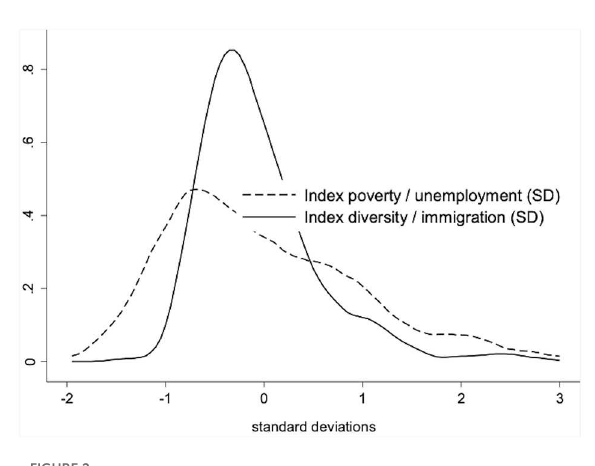
FIGURE2 Distribution neighborhood factors.